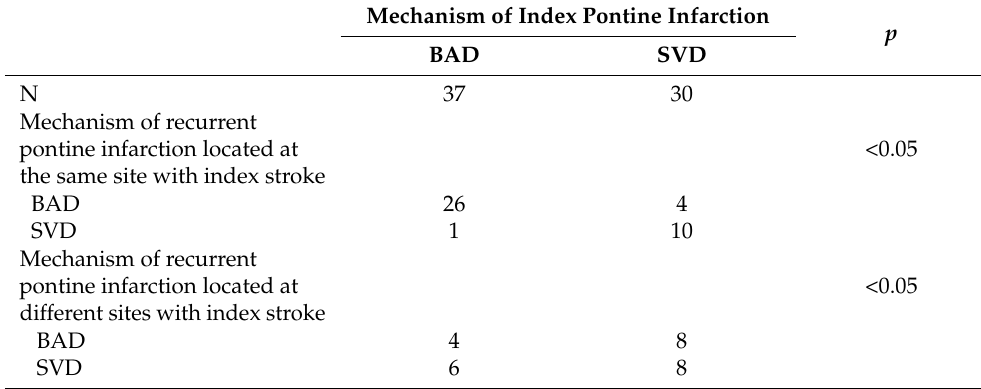
Table 3. Relationship of the mechanism of index pontine infarction with the site and mechanism of recurrent pontine